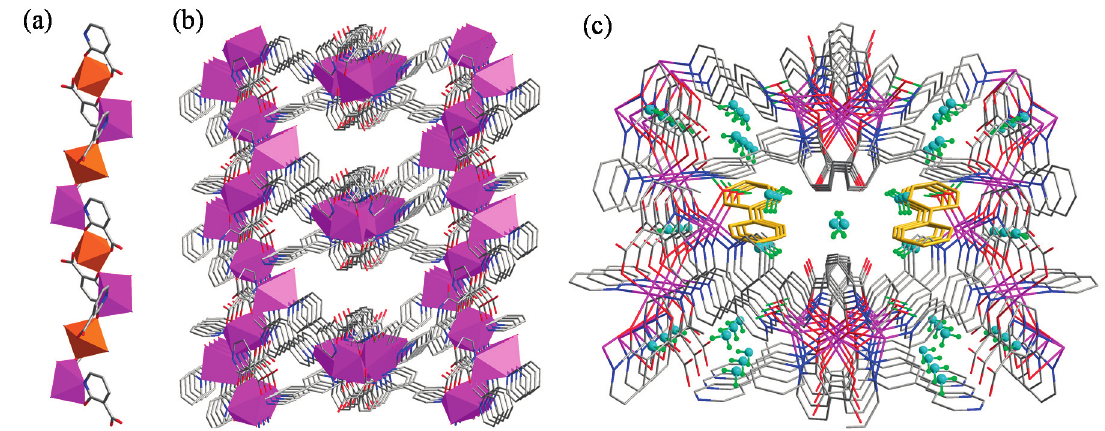
Figure 2. ( a ) Formation of metal chains in 1 through the coordination of nica 2 ‒ ligands in a chelating manner; ( b ) the 3D framework in 1 viewed along the c axis; ( c ) incorporation of guest molecules such as water and 4,4 ′